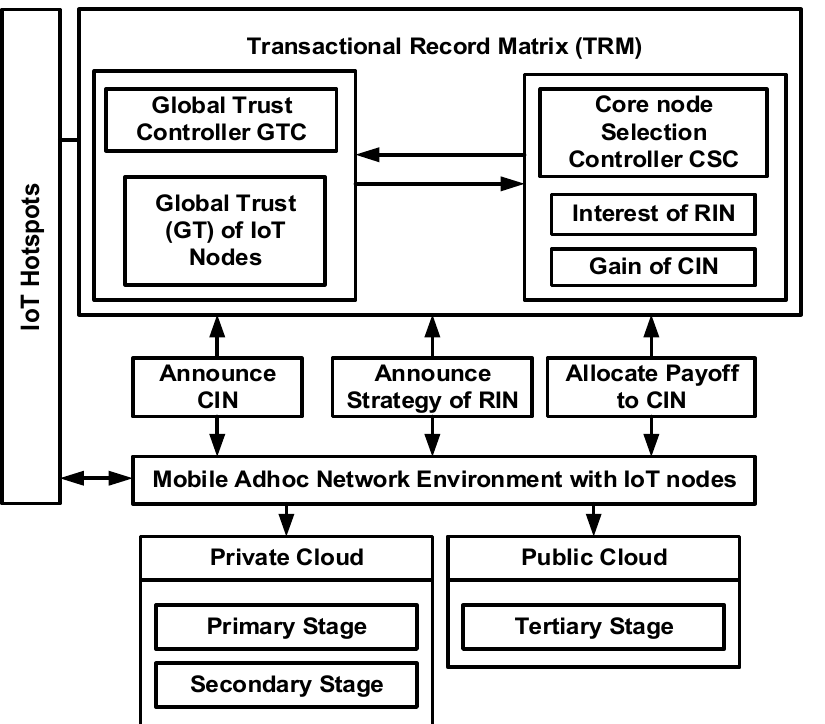
Figure 1. Proposed strategic game model for resisting malicious node participation formatting.